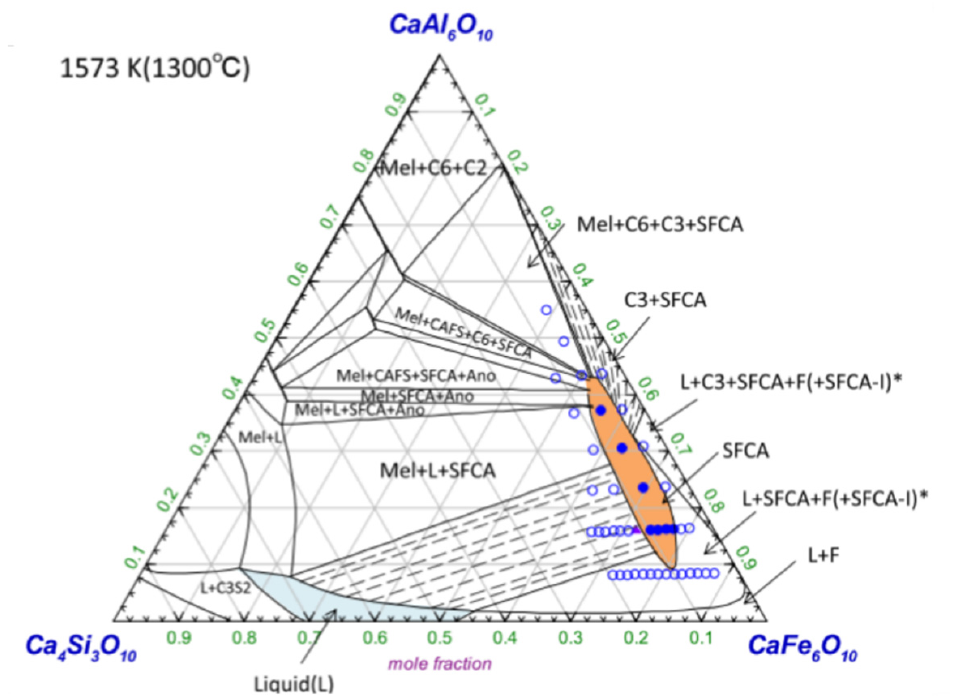
Figure 9. Isothermal phase diagrams of the CA3–CF3–C3S4 system, calculated using a thermody- namic model at 1573 K (filled circles: experimental data points for single-phase SFCA reported by Murao et al. [63]; filled circles: mixtures of SFCA and a meta-stable phase reported by Murao et al. [63]; open circles: a mixture of SFCA and other phases reported by Patrick and Pownceby [62]).